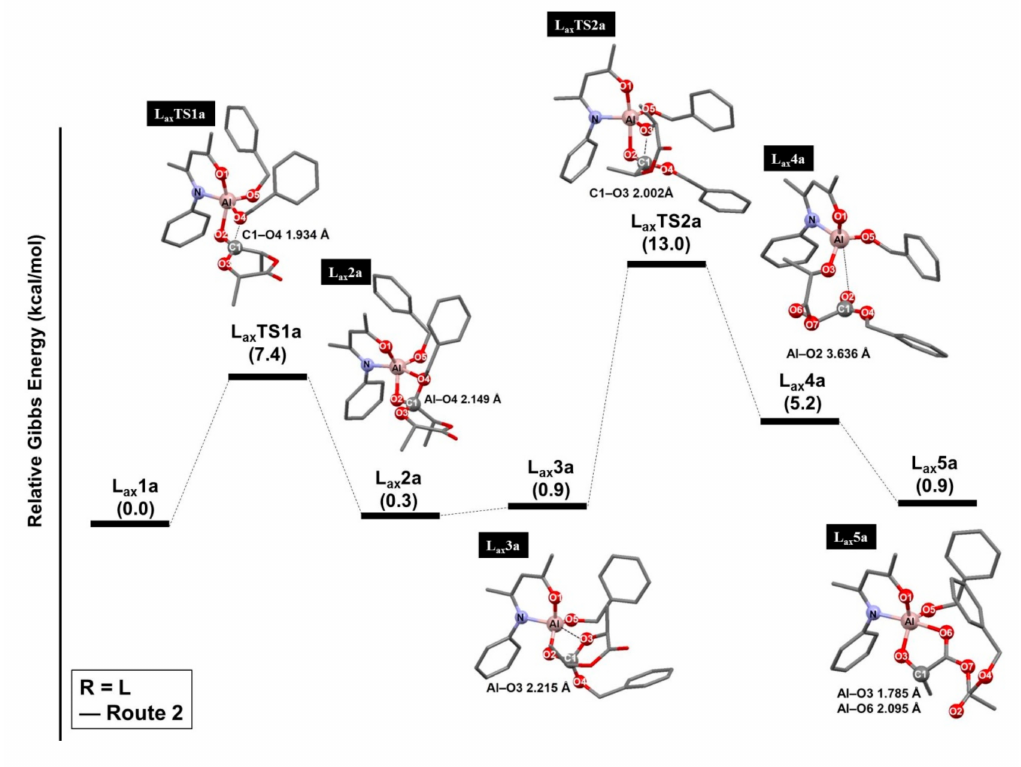
Figure 9. Reaction profile and optimized structures of the L system. (Monomer: L -lactide).